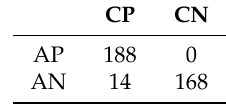
Table 5. Detection rate of dynamic hazardous objects in the diagonal direction (nighttime).